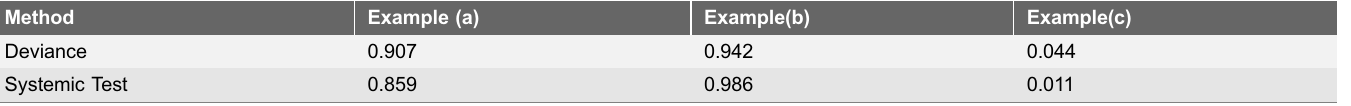
Table 4. P-values from the deviance and systemic tests resulting from the examples in Fig. 2.